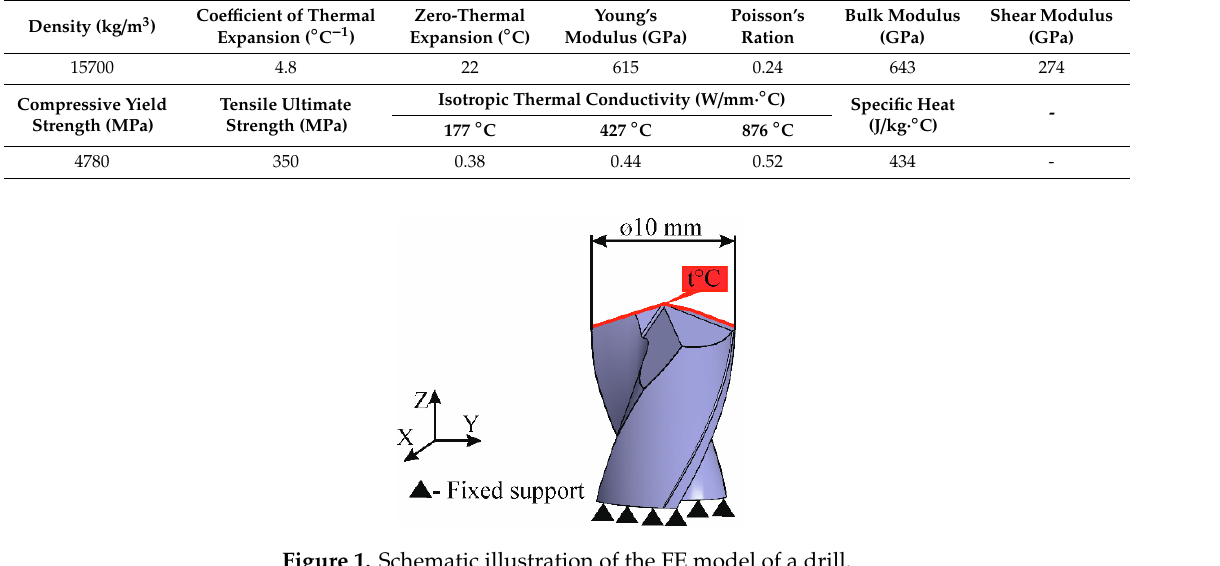
( b ) Figure 2. Results of finite element modeling of drill thermal expansion. 2.3. Experimental Setup In the present study, the experimental set up was implemented at the 5 axial DMU 85V CNC (Computer Numerical Control) milling center (DMG MORI, Pfronten, Germany) (Figure 3). The CFRP/Ti alloy sample was fixed on a new precise wise Schunk Kontec KSC-F-125 (SCHUNK GmbH & Co. KG, Lauffen/Neckar, Germany) with an error of location of 0.02 mm, which was clamped to the Dynamometer Kistler 9257 (Kistler Group, Winterthur, Switzerland) at the machine table. According to the aim of the study, during drilling trails, the thrust force and drilling temperature were measured. Thrust force was measured using a three-component dynamometer Kistler 9257 (Kistler Group, Winterthur, Switzerland) with a frequency of 200 Hz. The signal of the thrust force was transmitted to a multi-channel amplifier Kistler 5070 (Kistler Group, Winterthur, Switzerland), then to a A/D board and recorded on a personal computer (PC) using DynoWare software. The drilling temperature was measured via a rotating wireless temperature measuring system, which was clamped on an HSK63 collet chuck with a collet screw. The functioning of the system is based on a combination of Seebeck effect measurement with cold junction compensation and wireless high- frequency transmission of the thermocouple signal via Bluetooth channel. This system was powered using Li-ion batteries and consisted of a K-type thermocouple connected to a thermocouple signal amplifier, which transferred the signal to a Bluetooth module. After that, the wireless Bluetooth signal receiver captured the drilling temperature signal and transferred it to the PC with a USB interface converter to the COM port. Self-developed software captured the signal from the COM port and recreated it in real-time on the PC screen and into an Excel file. The thermocouple was embedded under the flank surface of the twist drill in a mechanically-grinded bind groove through the coolant hole at the distance of 1.3 mm from the cutting edge and 1.7 mm from the outer corner. The temperature measurement range of the K-type thermocouple was 40–1036 °C with an accuracy of 0.5 °C. The sampling frequency of the wireless temperature measuring system was 200 Hz, with a signal